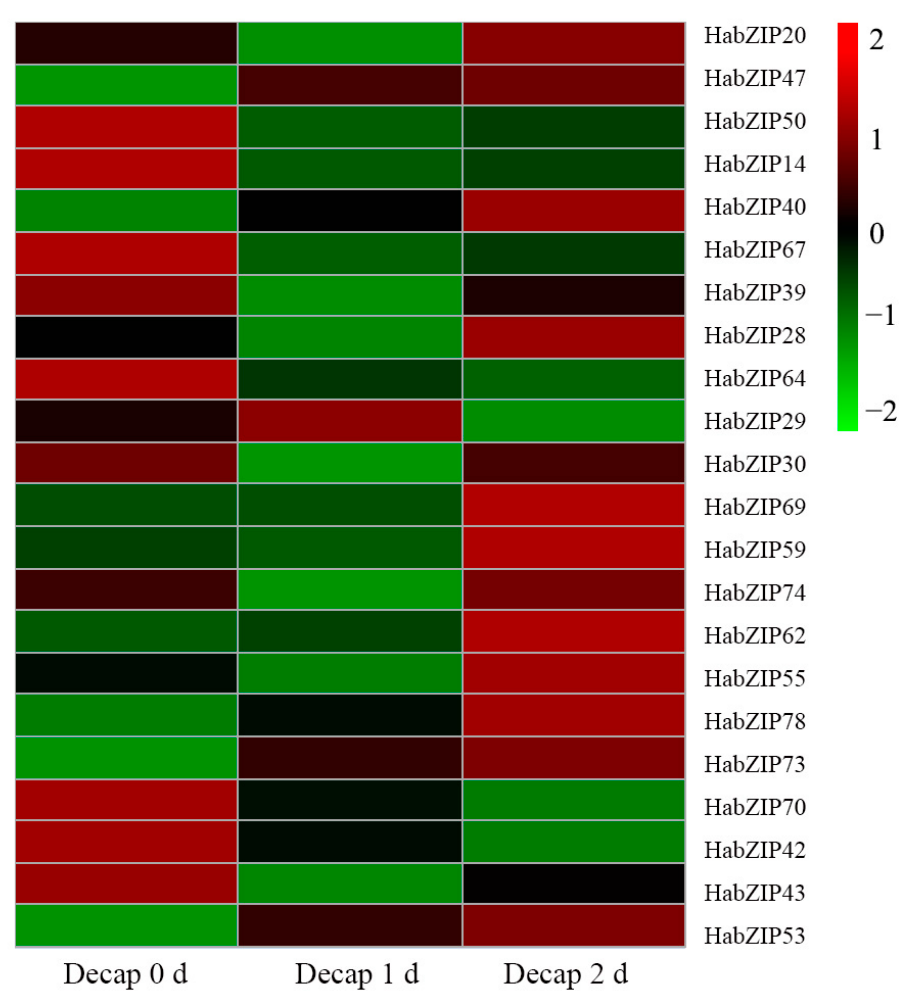
Figure 7. Response of the HabZIP genes to decapitation.